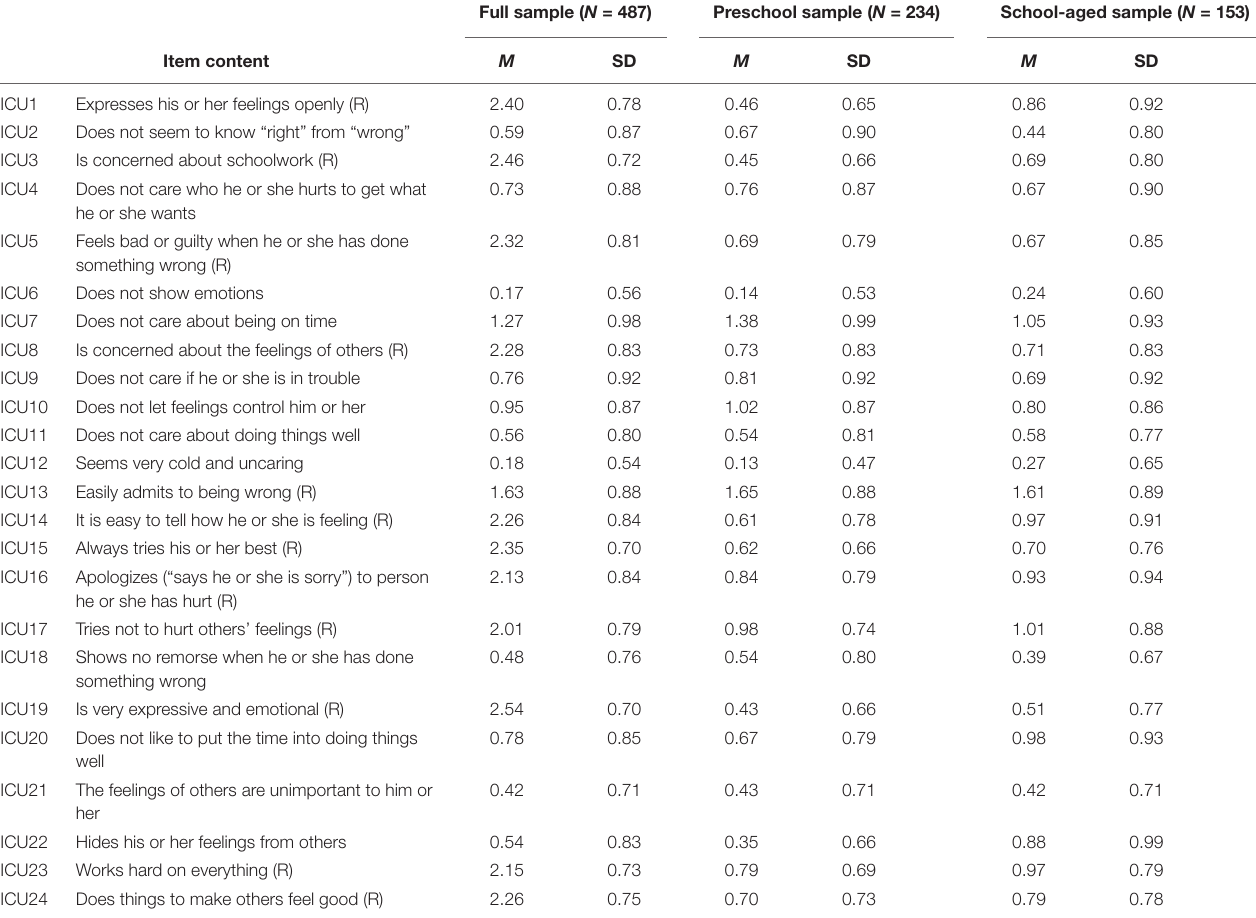
TABLE 1 | Descriptive statistics for the full sample and for preschool- and school-aged children separately. Full sample ( N = 487)